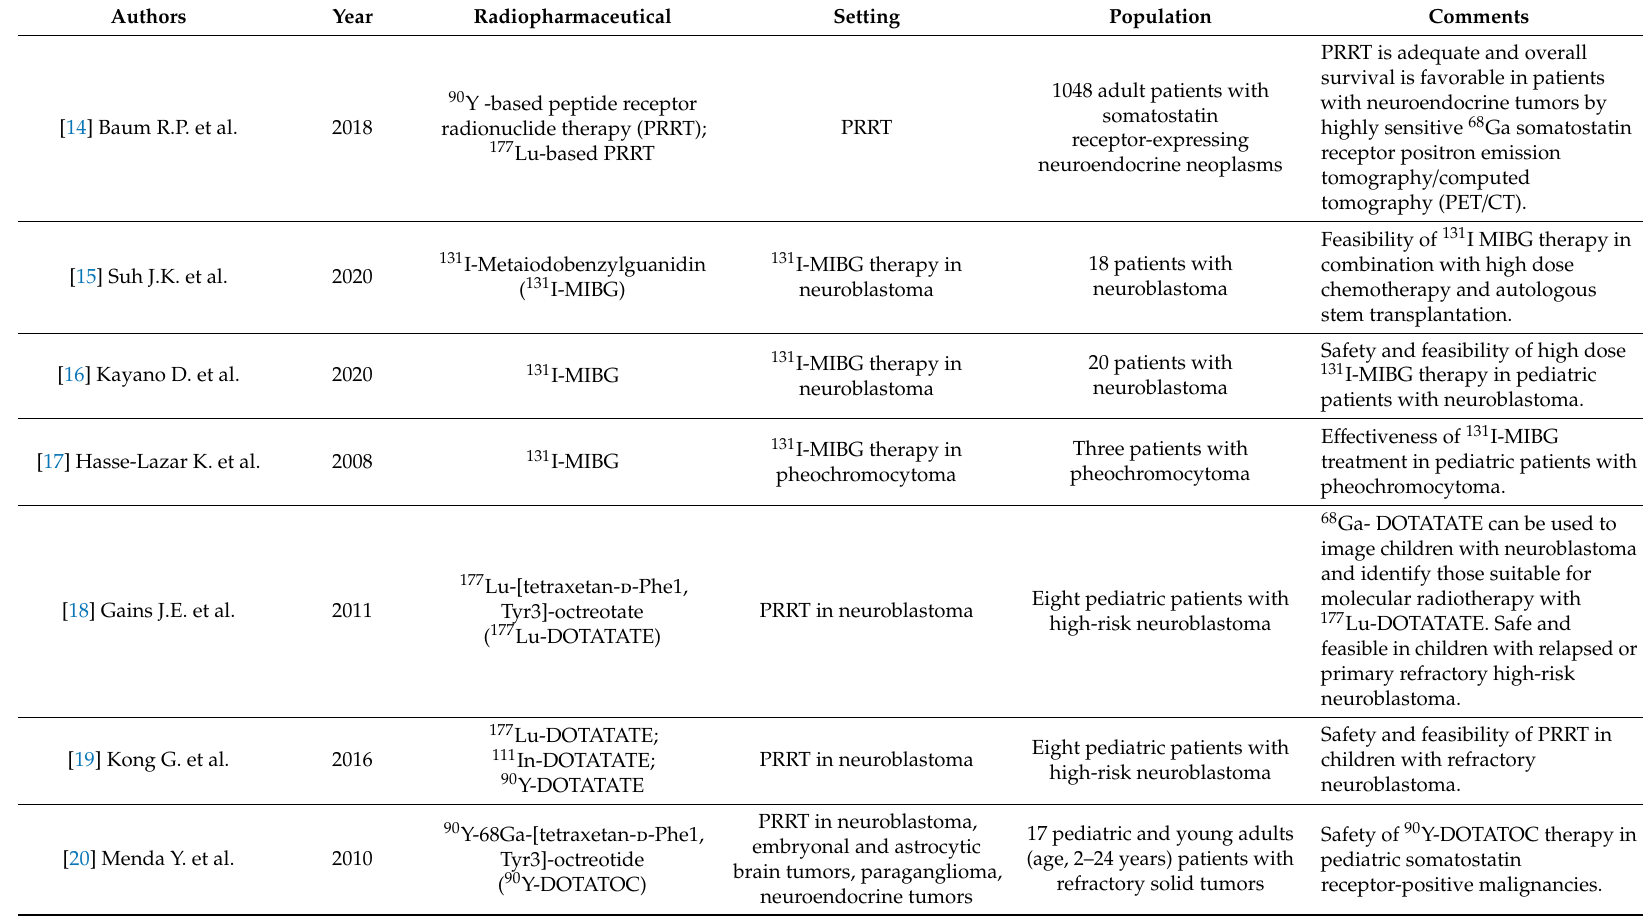
Table 1. Summary of the most relevant studies focused on theragnostics and radioimmunotherapy cited in the